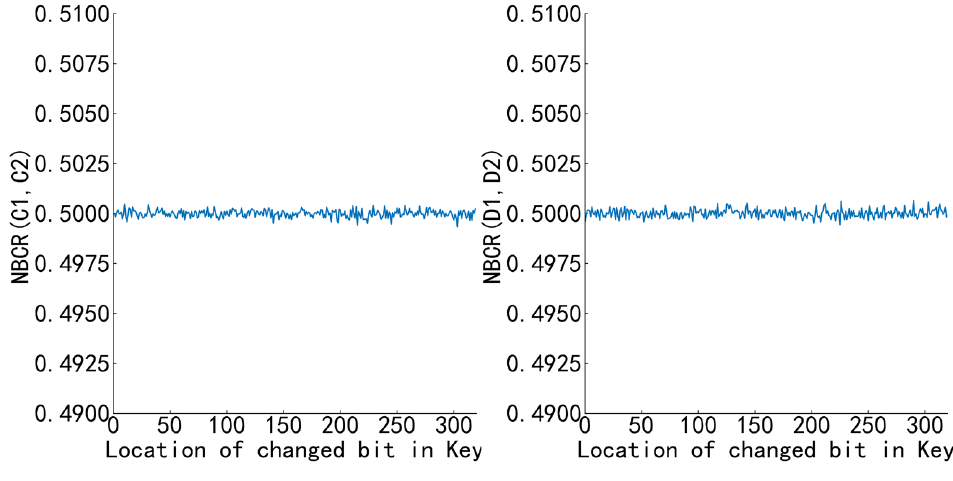
Figure 7. NBCR ( C 1 , C 2 ), NBCR ( D 1 , D 2 ). Figure 7. NBCR(